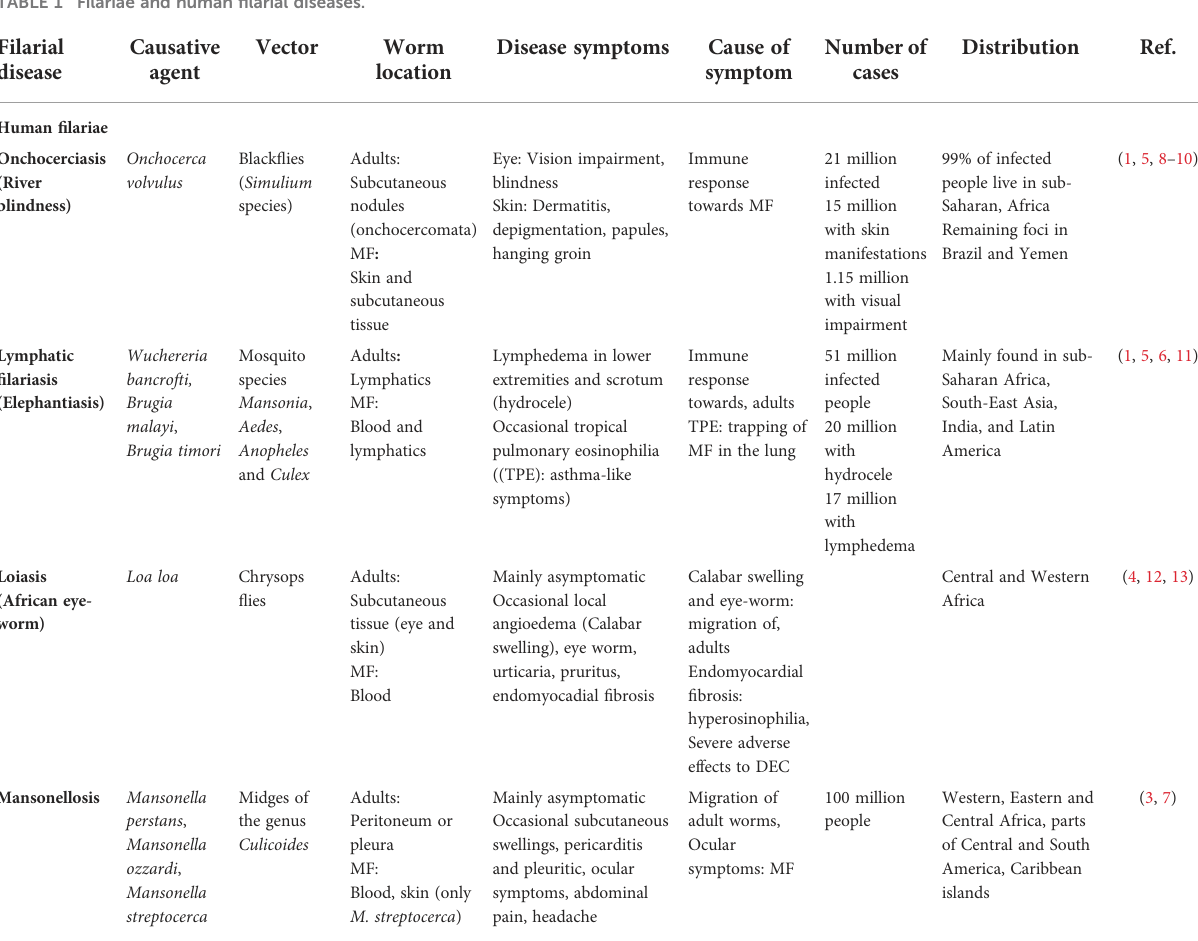
TABLE 1 Filariae and human fi larial diseases. Filarial